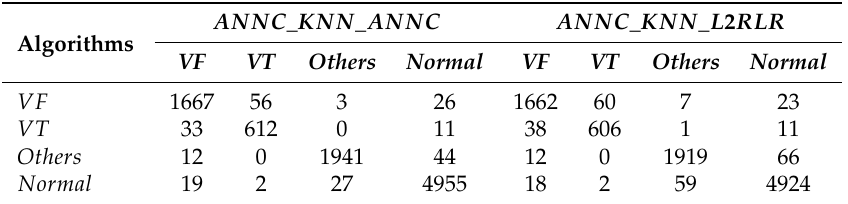
Table 11. Confusion matrix for classification of VF , VT , Others , and Normal using the